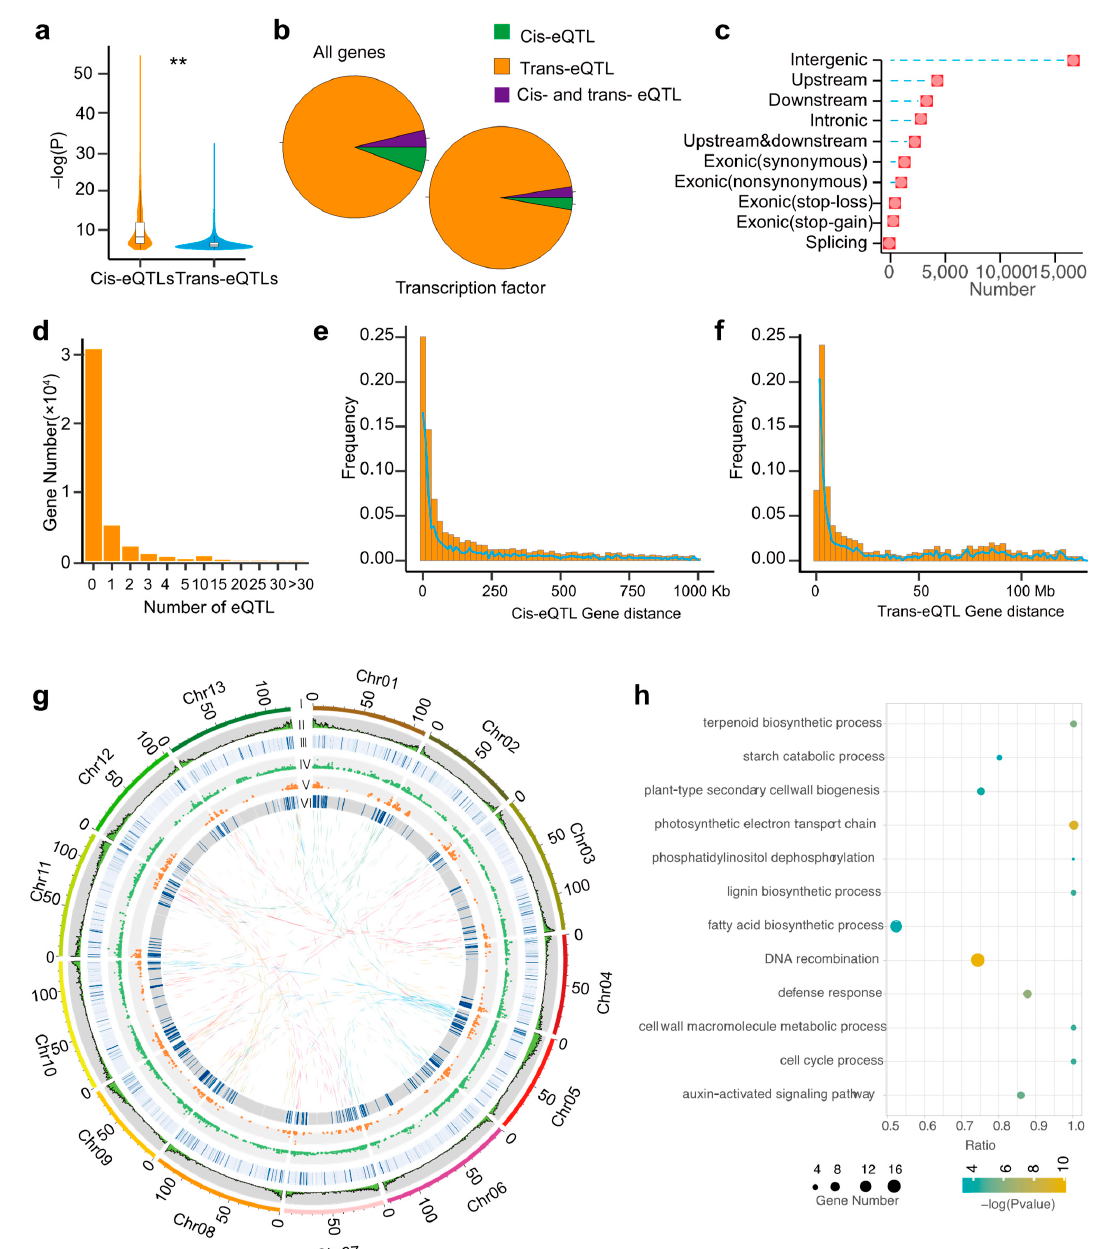
Figure 1. Characterization of eQTLs using RNA-Seq data of seedling samples. ( a ) The comparison of significance between cis-eQTLs and trans-eQTLs. Student‘s test, ** p < 1 × 10 3 ( b ) The proportion of eQTLs that are cis-eQTLs, trans-eQTLs, or are both cis-eQTLs and trans-eQTLs in the categories of all genes or transcription factors ( c ) Number of eQTLs belonging to each functional category. ( d ) Distribution of the number of eQTLs for genes which were regulated by eQTLs. ( e ) Distribution of the distance between cis-eQTLs and the genes they regulate. ( f ) Distribution of distance between trans-eQTLs and the genes they regulate. ( g ) Integration of eQTLs and hotspots. I—the thirteen chromosomes of Gossypium arboreum . II—gene density in a 1 Mb window. III—heatmap of gene FPKM. IV—trans-eQTLs ( p < 1 × 10 5 ) association plot. V—cis-eQTLs ( p < 1 × 10 5 ) association plot. VI—histogram of hotspots. ( h ) Functional enrichment analysis for eQTL-regulated